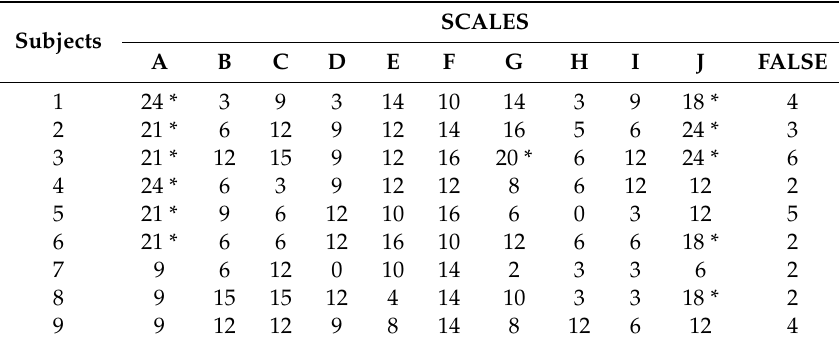
Table A1. Scores of Shmishek-Leonhard